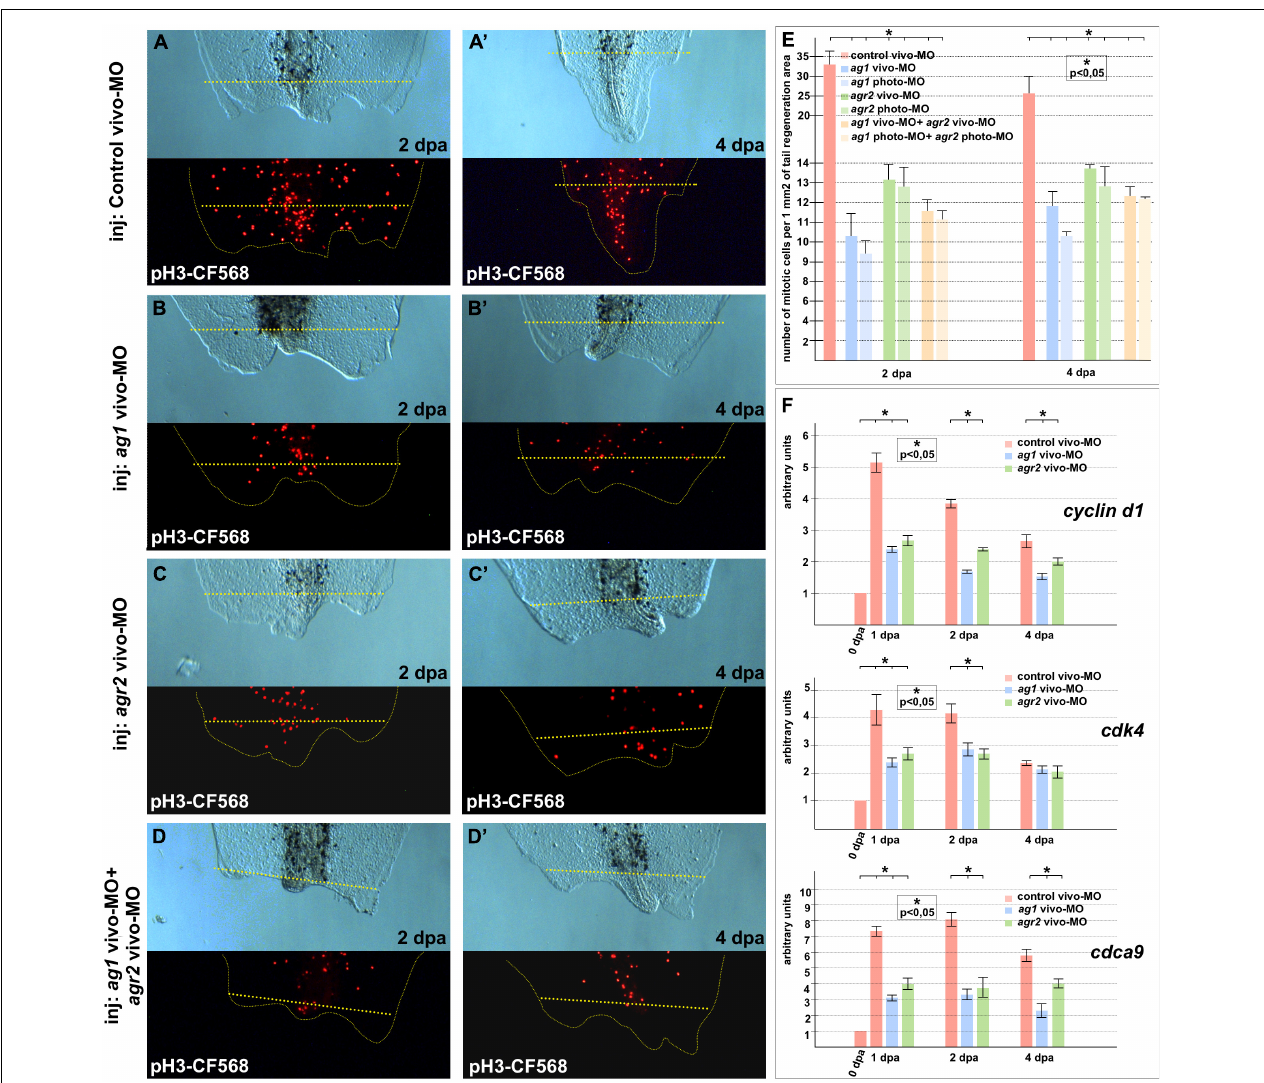
FIGURE 2 | Cell proliferation is inhibited in regenerating tails under ag1 and/or agr2 downregulation conditions. (A,A’) The transmitted light and fluorescent images of regenerating tails of tadpoles injected with solution of control vivo-MO after immunostaining with primary rabbit anti-pH3 and secondary anti-rabbit antibodies conjugated with red fluorescent protein CF568 demonstrate mitotic activity in the regenerating area at 2 and 4 dpa, respectively (see E for statistics). Transmitted light and immunostained fluorescent images of tadpoles injected with ag1 vivo-MO (B,B’) , agr2 vivo-MO (C,C’) , or a mixture of them (D,D’), show strong inhibition of mitotic activity at 2 and 4 dpa. Dashed yellow line indicates amputation level. (E) Quantification of number of mitotic cells per 1 mm2 of tail regenerating area. Data of five independent experiments (10 tadpoles of each injection type were used in 1 experiment) were used for statistical analysis; statistical significance was determined by t -test for independent samples, p < 0.05 (asterisk). Error bars indicate SD. (F) qRT-PCR analysis of expression levels changes of cell cycle markers cyclin d1, cdk4, and cdca9 during the regeneration process (at 0, 1, 2, and 4 dpa) in amputated tails of tadpoles injected with control , ag1 and/or agr2 vivo-MO. The value of normalized PCR signal in the 0 dpa sample, harvested immediately after amputation, was taken as an arbitrary unit in each series. Dpa—days post amputation. Error bars indicate SD, t -test, p < 0.05